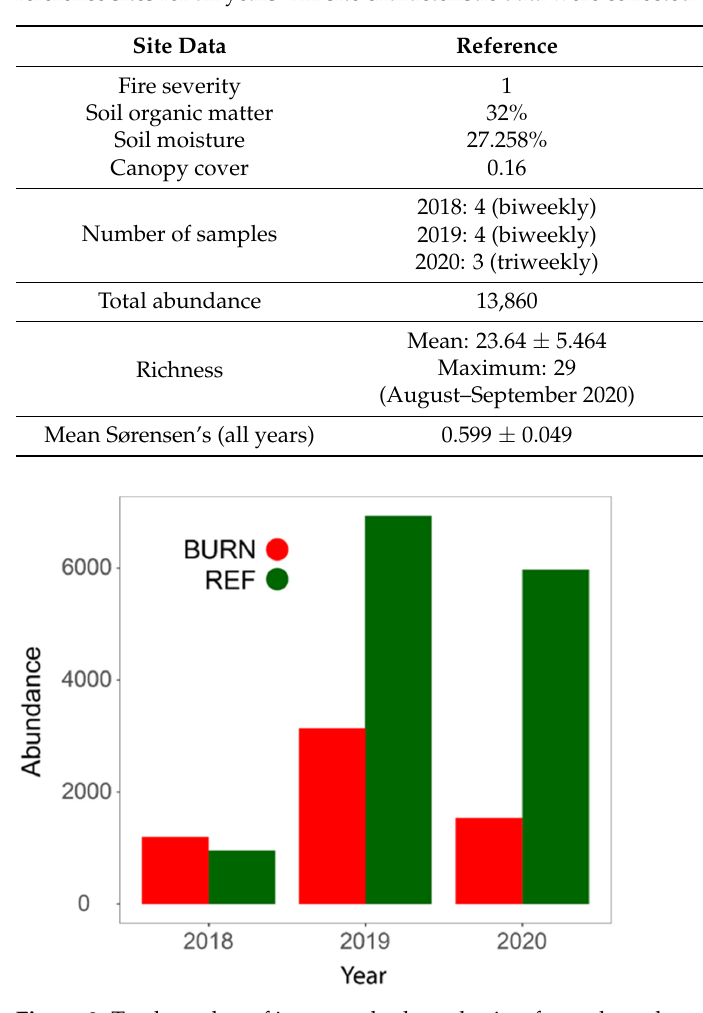
Figure 3. Total number of insects at both study sites for each study year.